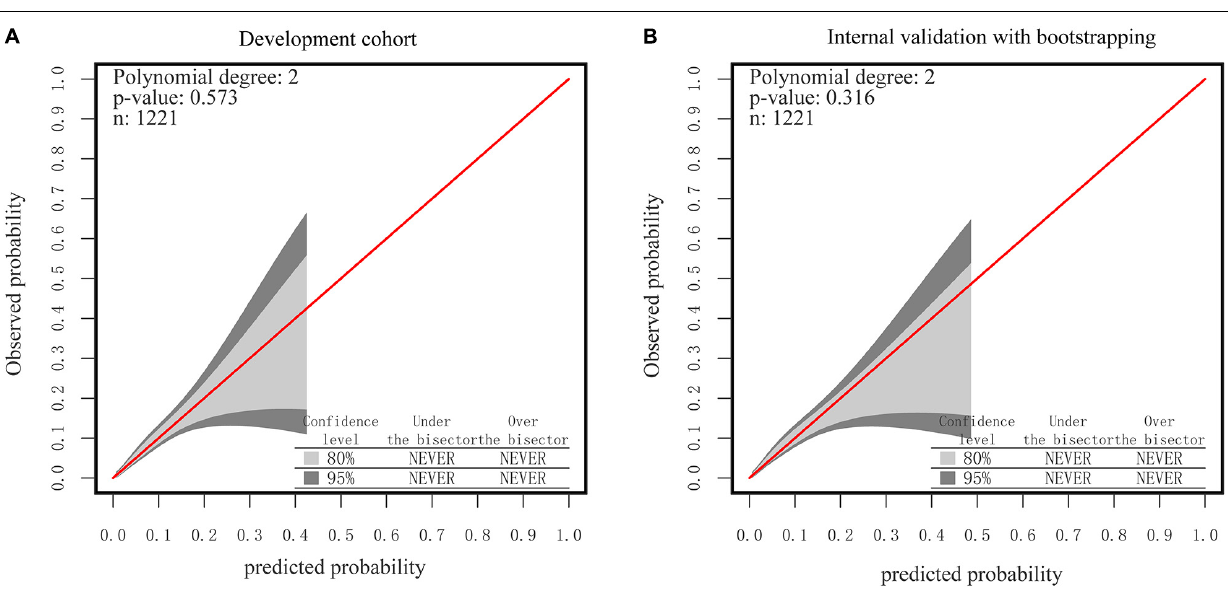
FIGURE 6 | The GiViTI calibration belt for the nomogram. (A) The development Cohort. (B) The internal validation cohort. Note: the 80%CI and 95%CI calibration belt are plotted, in light and dark gray, respectively. The red diagonal line is the reference line indicating perfect calibration. Note: the red line represents the best-fit line, and the blue lines are 95% confidence